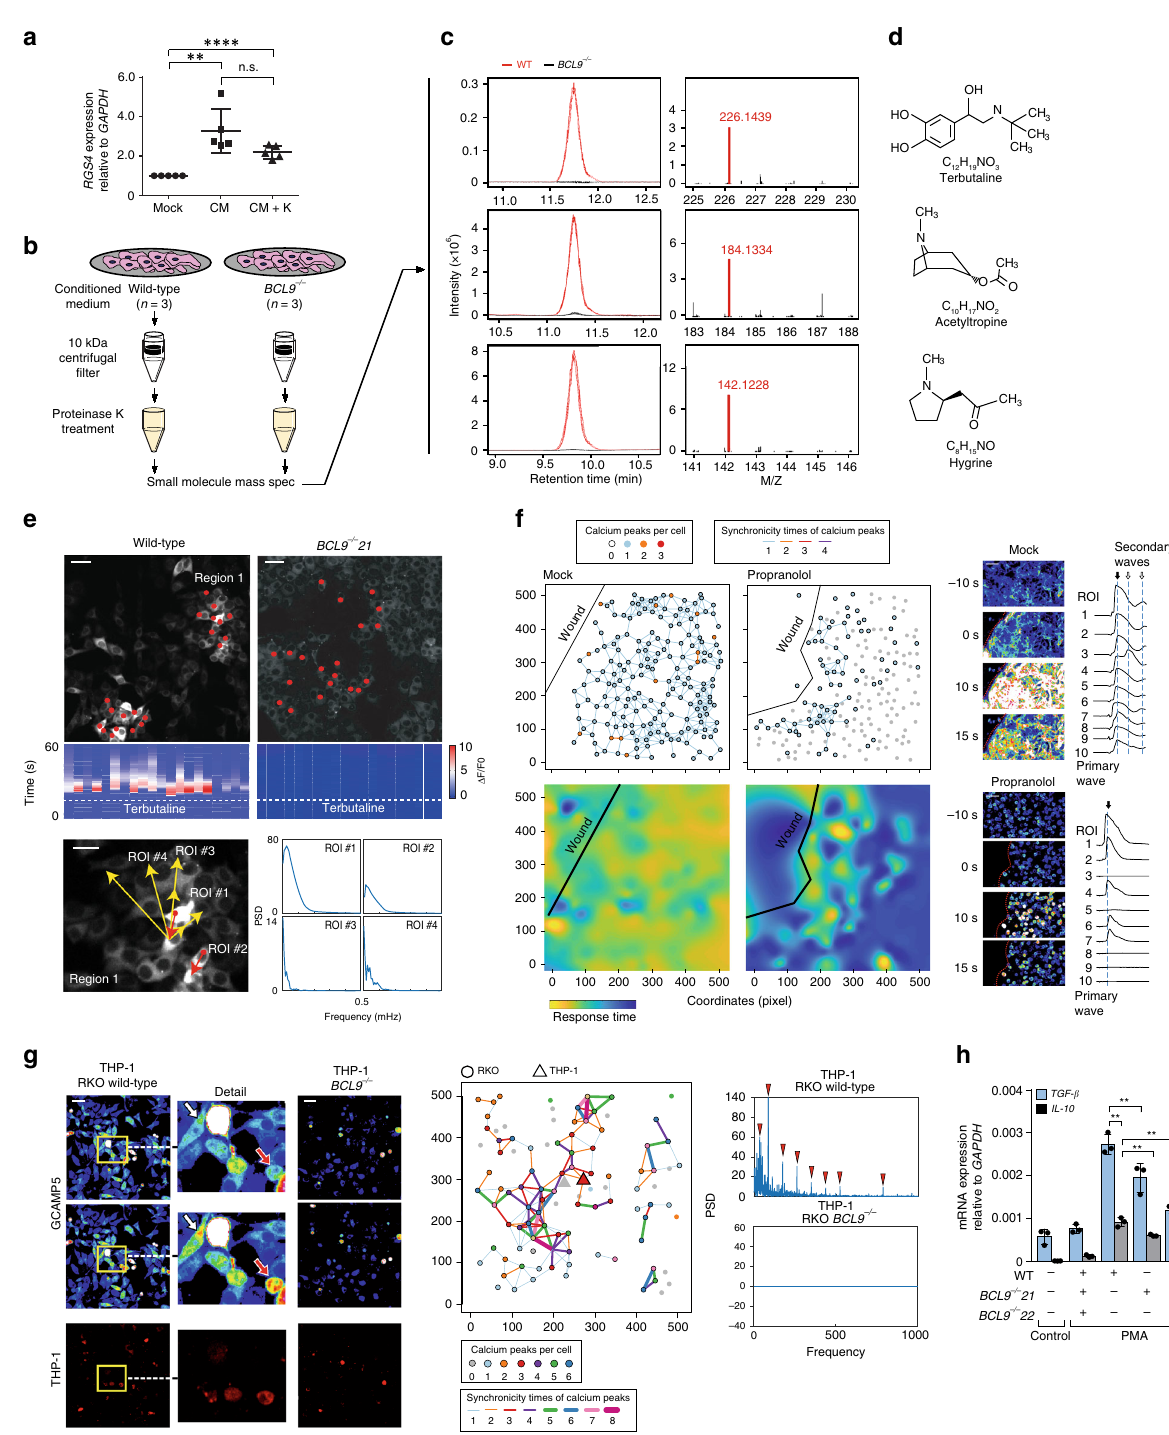
RGS4 , a regulator of alpha units of heterotrimeric G proteins 46 which is broadly expressed in excitable tissues such as brain cortex 47 and smooth muscle 48 . Other mRNAs stabilized by BCL9 include the calcium channel encoding genes CACNA2D1 ; they are also highly expressed in neuronal cells and their opening is triggered by cell membrane depolarization and G-protein sig- naling activation 49 . The role of BCL9 in neuronal cells was sup- ported by high BCL9 expression in ganglion cells but not in normal colon epithelial cells. In addition, an association between abnormal expression of BCL9 in the brain cortex and negative